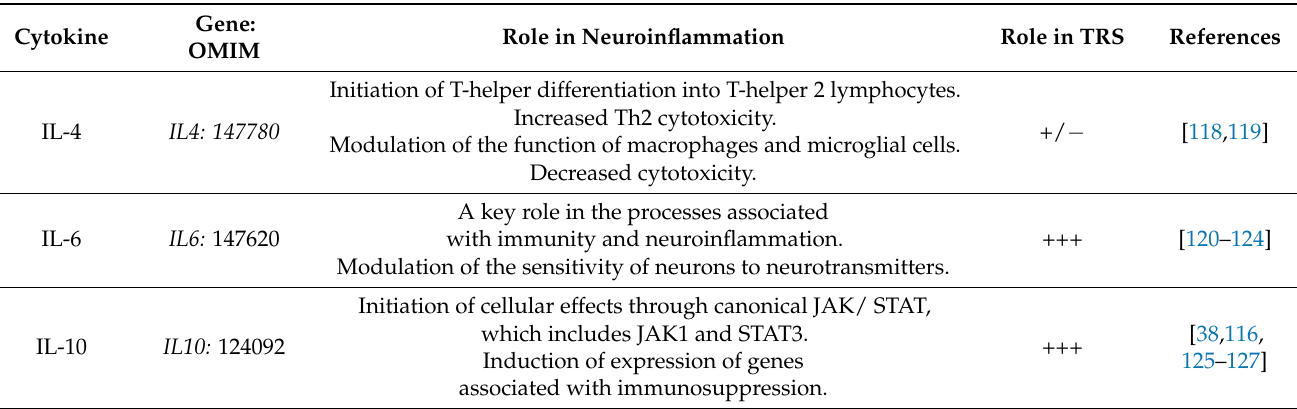
Table 5. Role of anti-inflammatory cytokines in treatment-resistant